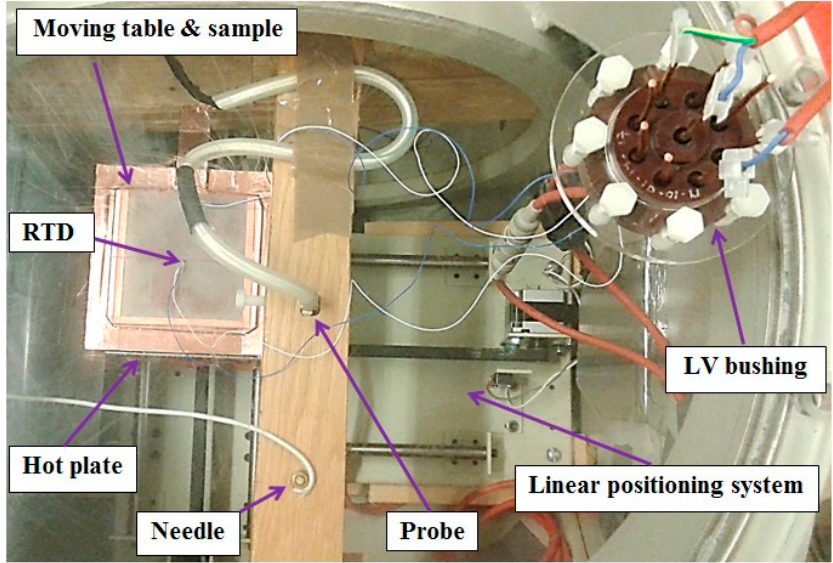
Figure 1. Top view of the set-up for surface potential decay (SPD) measurements. The movable table with the material sample is intentionally shifted to the left from its normal position for visibility. The table motion is in x-y plane (horizontally and vertically in the picture plane) and its motion and position are programmed from the external control unit. The corona needle and the potential probe are mounted on the wooden arm and are directed downwards to the sample (therefore, not visible on the photograph). RTD indicates position of the temperature sensor during the analysis of thermal conditions (was removed during SPD measurement).